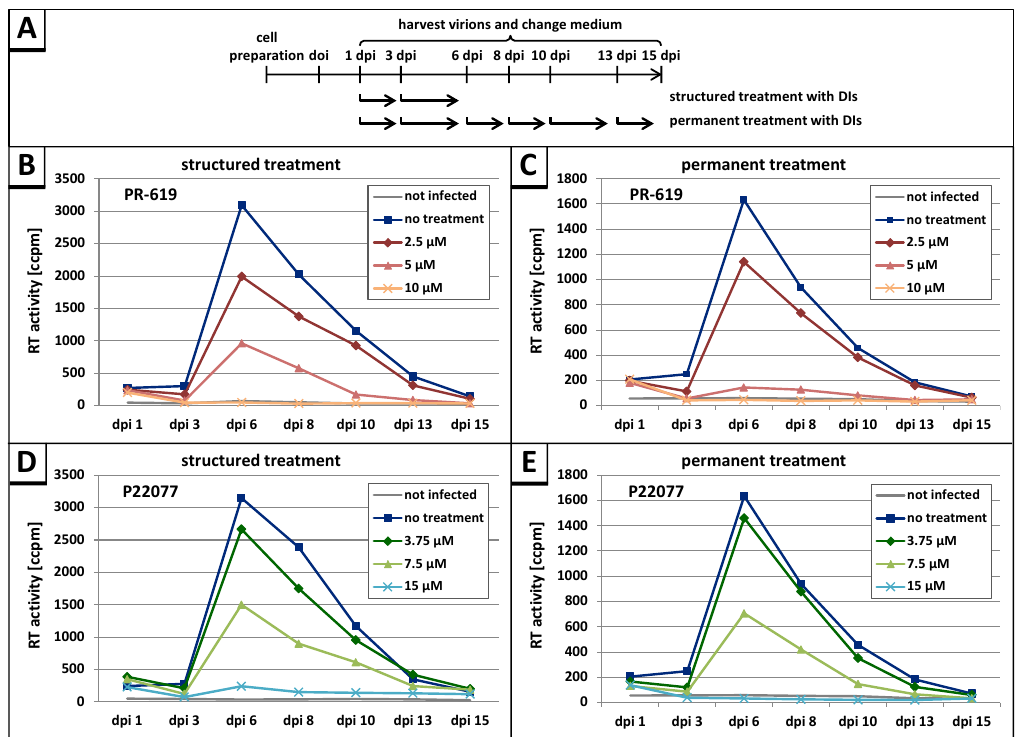
Figure 4. Treatment with PR-619 and P22077 reduces the replication capacity of HIV-1 in human lymphoid aggregate cultures (HLAC). ( A ) Schedule of structured and permanent treatment of HLAC with DIs; ( B – E ) A representative replication profile of HIV-1 NL4-3 (X4) is shown with structured ( B ) or permanent ( C ) treatment of HLAC with 2.5 μM, 5 μM, or 10 μM PR-619 and structured ( D ) or permanent ( E ) treatment of HLAC with 3.75 μM, 7.5 μM, or 15 μM P22077 following infection with